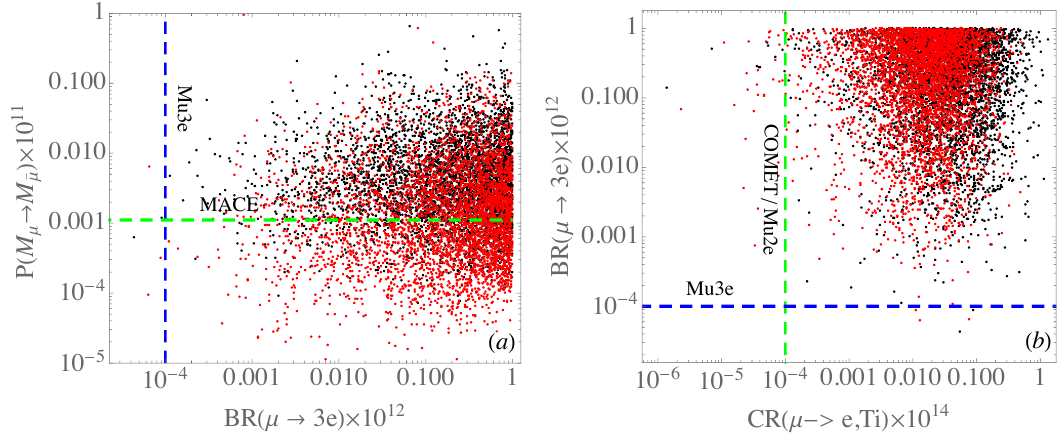
Figure 7 . Correlation between BR ( µ → 3 e ) and (a) P ( M µ − M µ ) and (b) CR ( µ − e, Ti) , where the dashed lines label the experimental sensitivities. The black and red points denote the results of NO and IO,